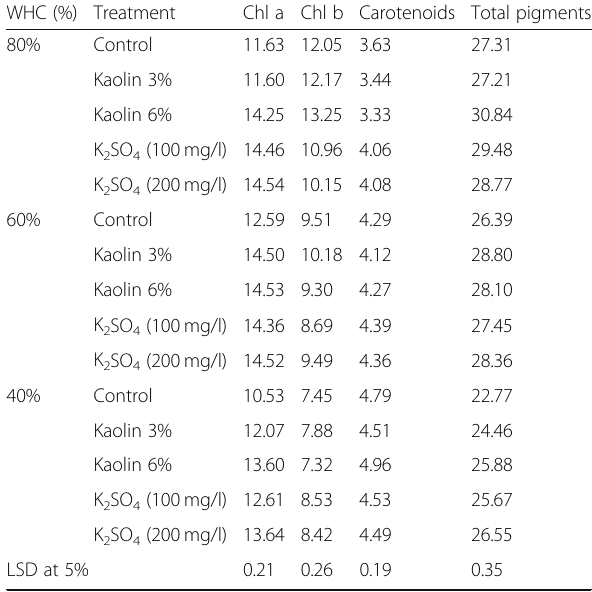
Table 3 Effect of different concentrations of kaolin or K under different levels of water holding capacity on photosynthetic pigments ( μ g/g fresh weight) of wheat plants after 75 days from sowing (combined analysis of two seasons)